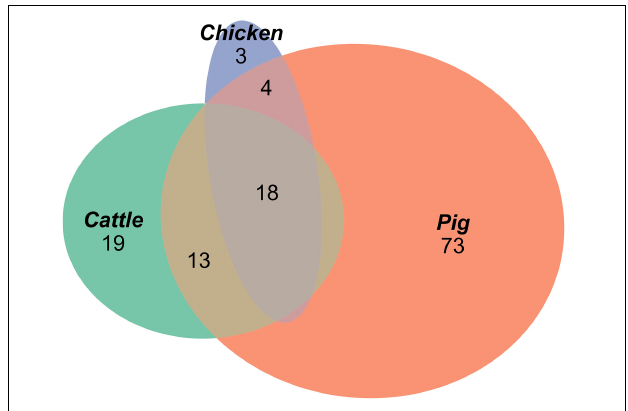
FIGURE 1 | Proportional elliptical Venn diagram of AMR profiles of isolates from pig, cattle and chicken sources.